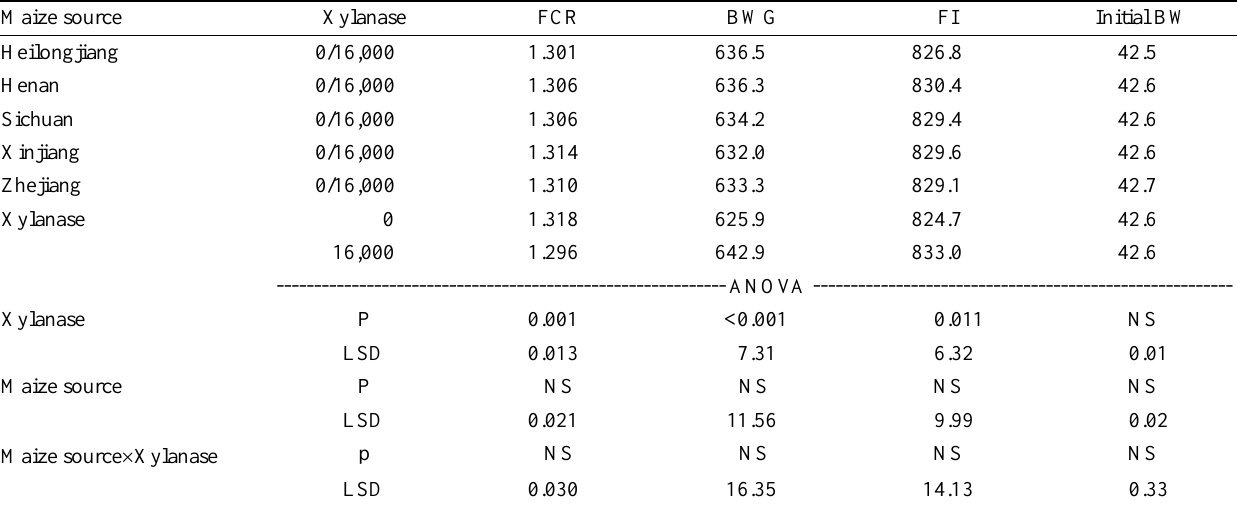
Table 5. Analysis of variance of the effect of maize source and xylanase dose on FCR, BWG and